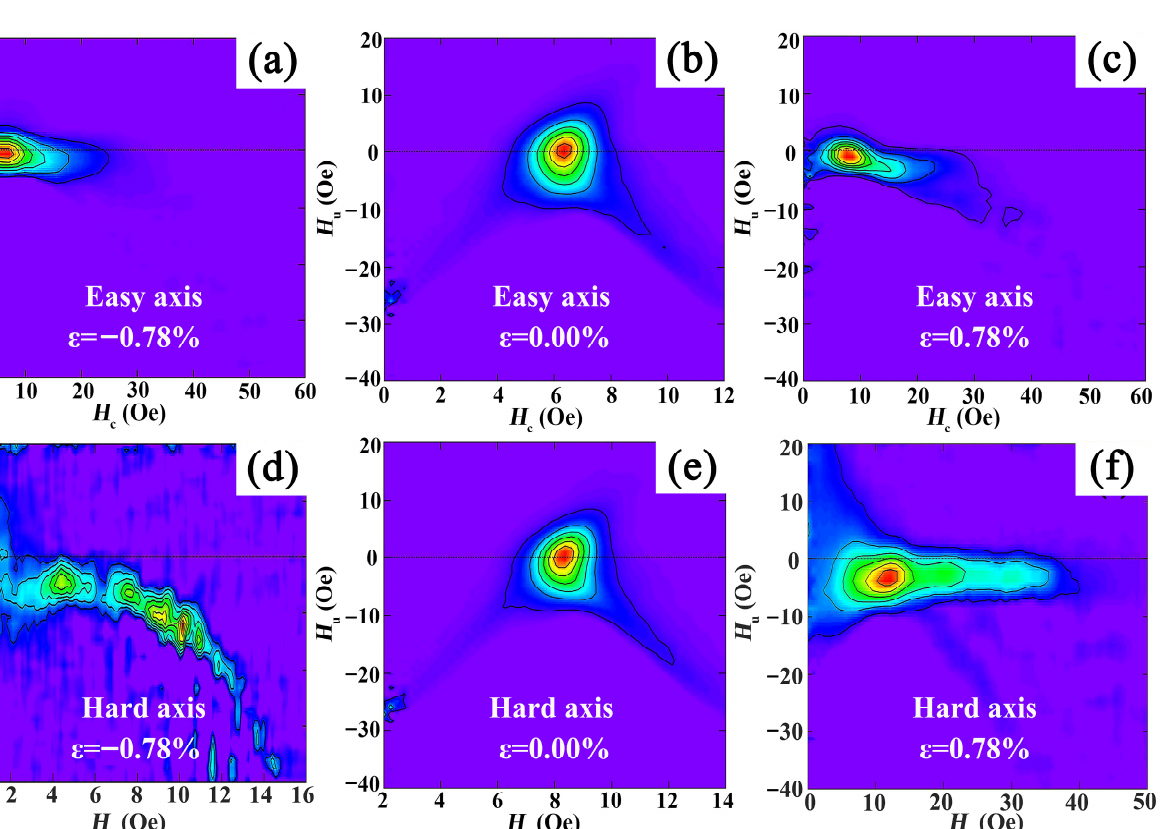
Figure 6. FORC diagrams of TFNFT multilayer films at various external strains: ( a ) ε = − 0.78%, ( b ) no strain, ( c ) ε = 0.78% (along the EA); ( d ) ε = − 0.78%, ( e ) no strain, ( f ) ε = 0.78% (along the HA).